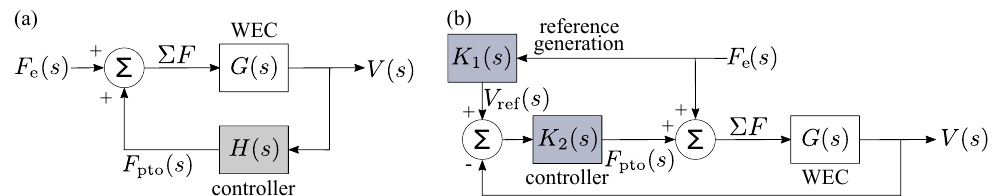
Figure 18. ( a ) Approximate complex conjugate (ACC) and ( b ) approximate velocity tracking (AVT) control